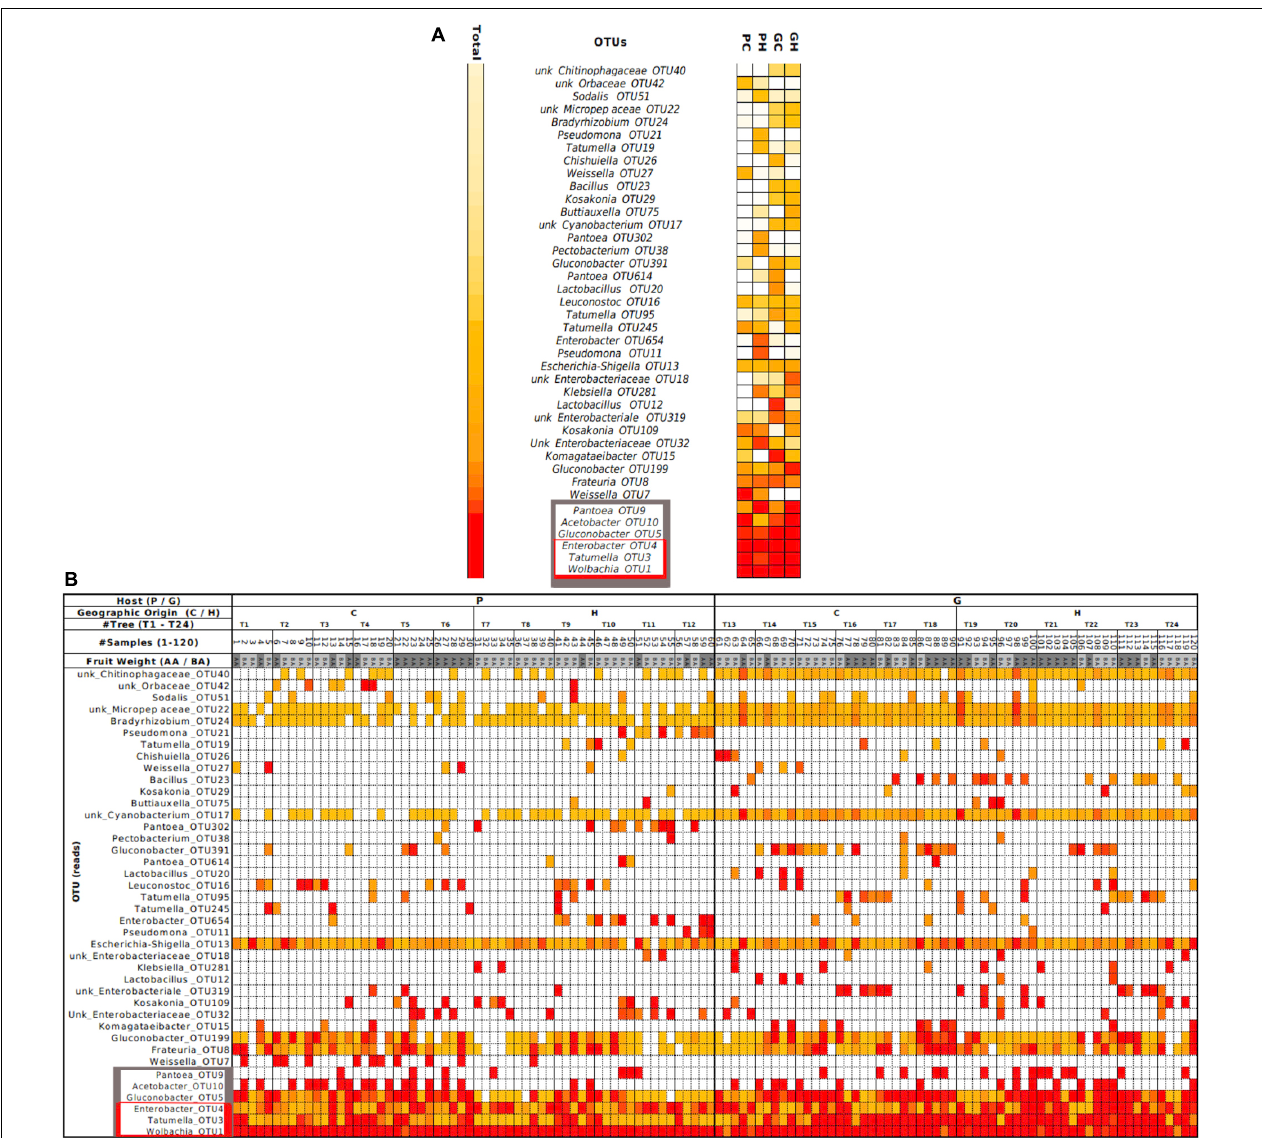
FIGURE 2 | The heatmap presents each of the OTUs identified in the gut bacteriome of wild Anastrepha fraterculus larvae, ordered from top to bottom according to total counts. (A) Summary of counts grouped by host and origin (PC, peach sampled in Concordia; PH, peach sampled in Horco Molle; GC, guava sampled in Concordia; GH, guava sampled in Horco Molle). (B) Complete dataset visualization ordered by total reads (see data in Supplementary Table 2 ). Color assignment: red: 90th percentile; orange: 50th percentile; white: 0 read. AA, fruit weight above mean weight; BA, fruit weight below mean weight (estimated separately for each host fruit